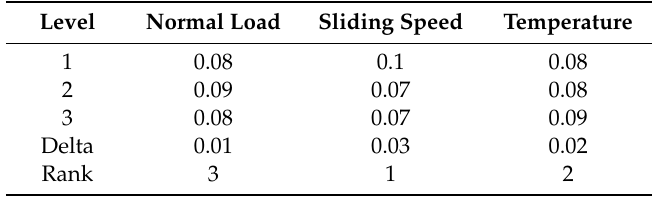
Table 5. Response table for mean SWR showing the ranking of the factors.